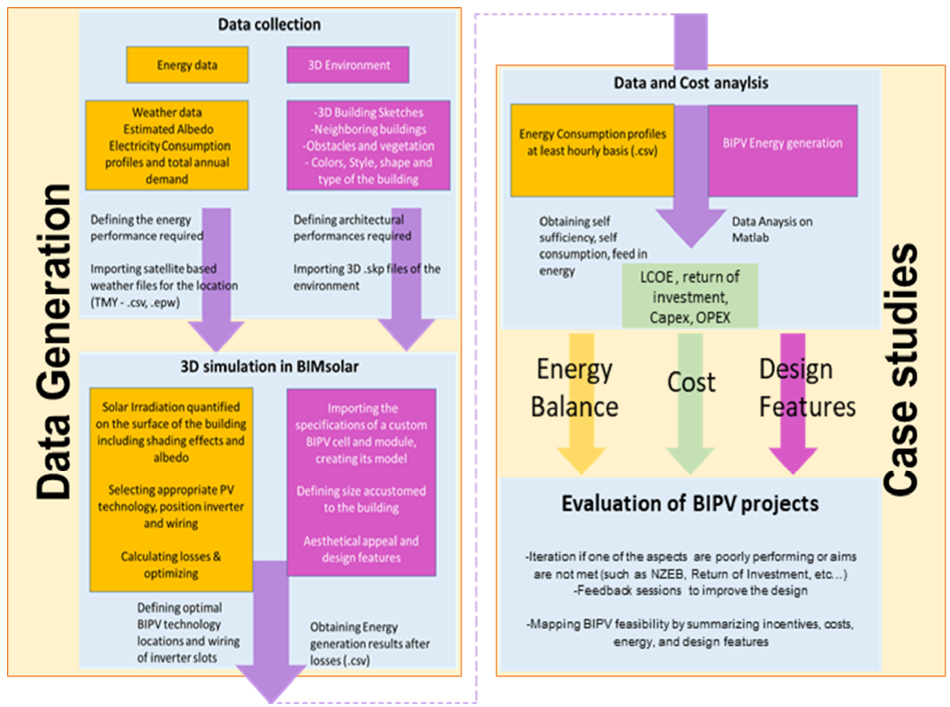
Figure 1. Summary of the modelling steps, data analysis, and evaluation of the projects.